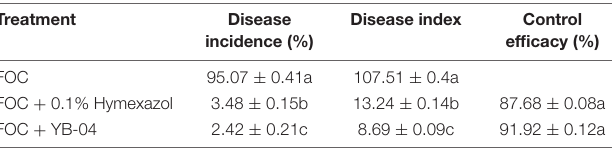
TABLE 1 | Disease incidence, disease index, and control efficacy of B. subtilis YB-04 against cucumber Fusarium wilt.